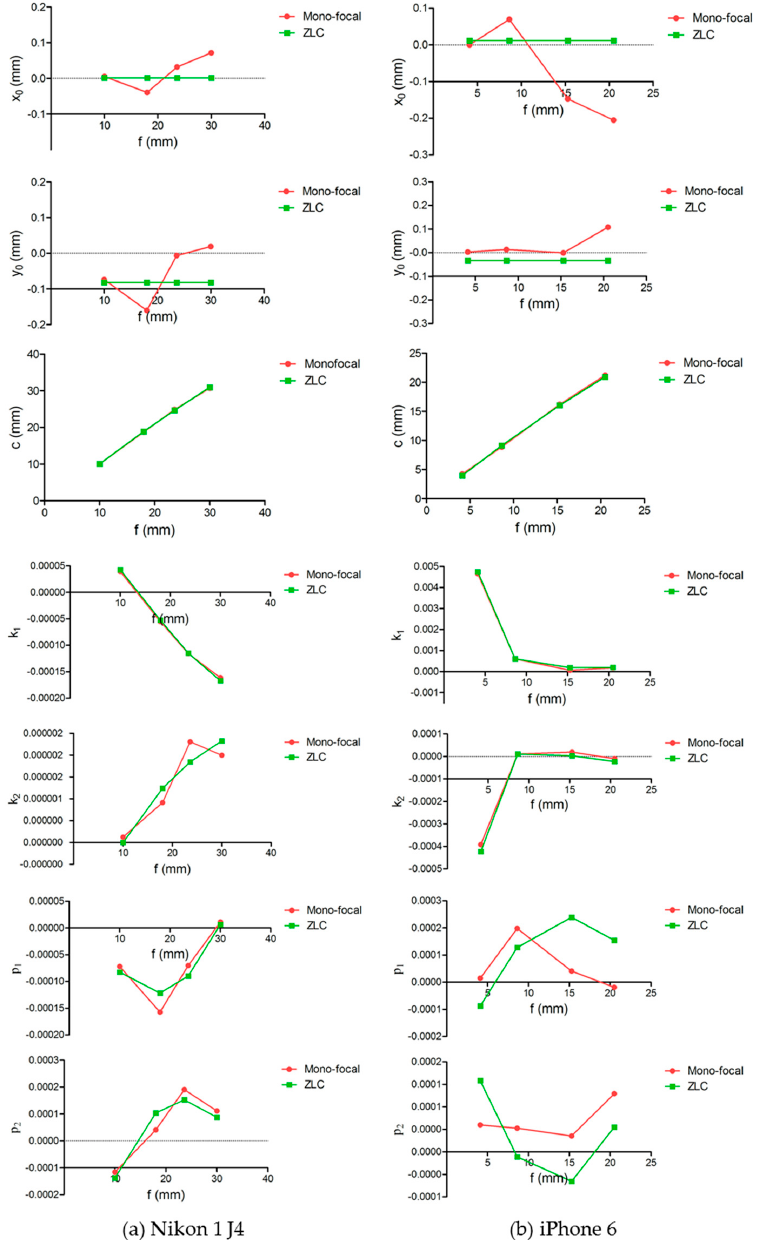
Figure 5. Comparison of intrinsic parameters determined by zoom lens calibrations (denoted as ZLC) and mono-focal calibrations for the two cameras: ( a ) Nikon 1 J4 and ( b ) iPhone 6.